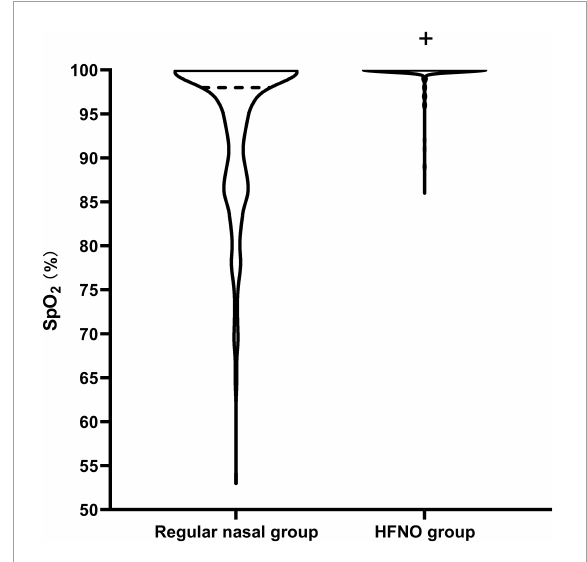
FIGURE4 Diagram of the minimum SpO 2 during the procedure. The violin plot visually represents the distribution of minimum SpO 2 . The minimum SpO 2 during the procedure was 98% [12% (53–100%)] in the regular nasal group and 100% [0% (86–100%)] in the HFNO group ( + P < 0.001). In the regular nasal group, the dark dotted line represents the medium SpO 2 and is located at 98%, representing that most patients could maintain SpO 2 at 98%. The lowest dotted line at 53% indicates there had one patient who experienced severe hypoxia in the study. Almost all patients in the HFNO group were able to maintain an oxygenation level of 100%, and patients seldom experienced hypoxia. No patients in the HFNO group experienced severe hypoxia.